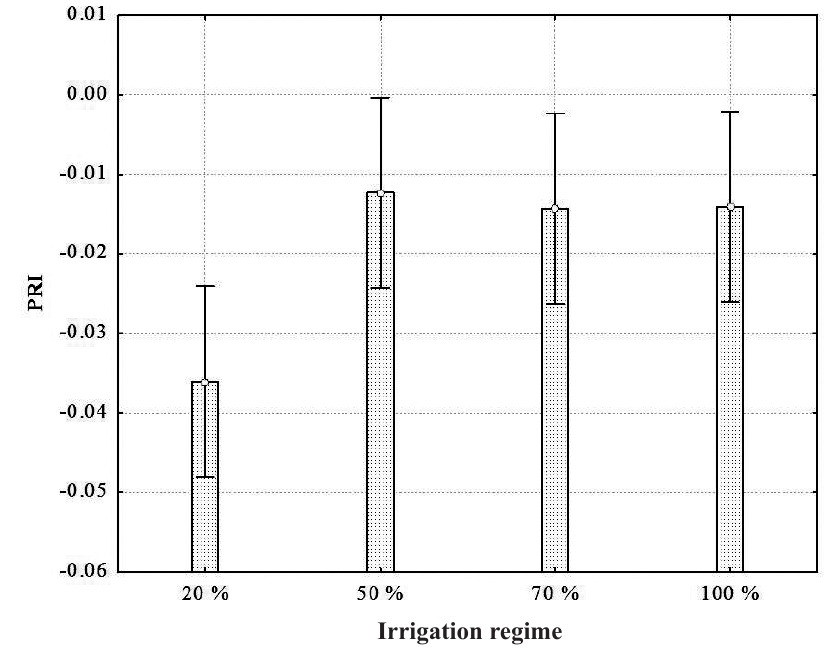
Figure 3. Mean photochemical reflective index (PRI) values as measured on 9 March 2006 for potted grapevines re- ceiving 20, 50, 70% and optimal (100%) irrigation. Vertical bars denote confidence intervals at P= 0.05.